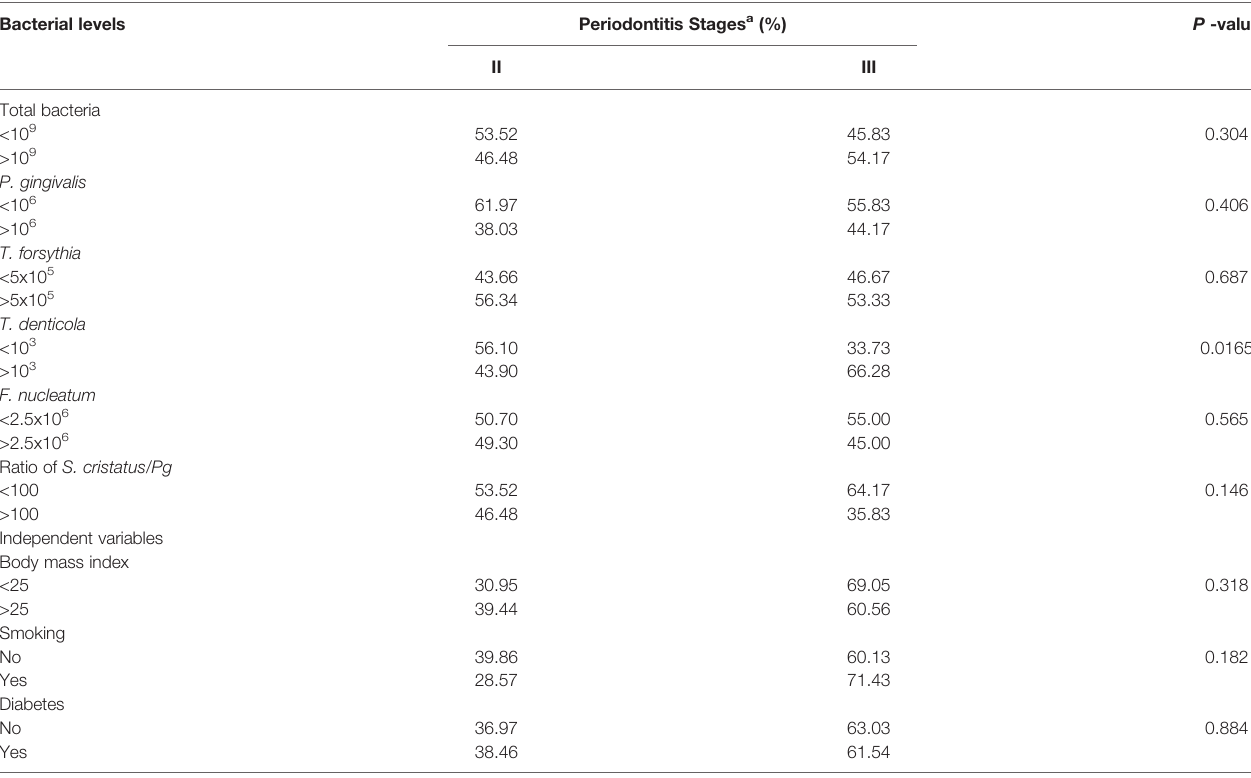
TABLE 6 | Correlation between oral bacterial levels or independent variables and periodontal disease stages. Bacterial